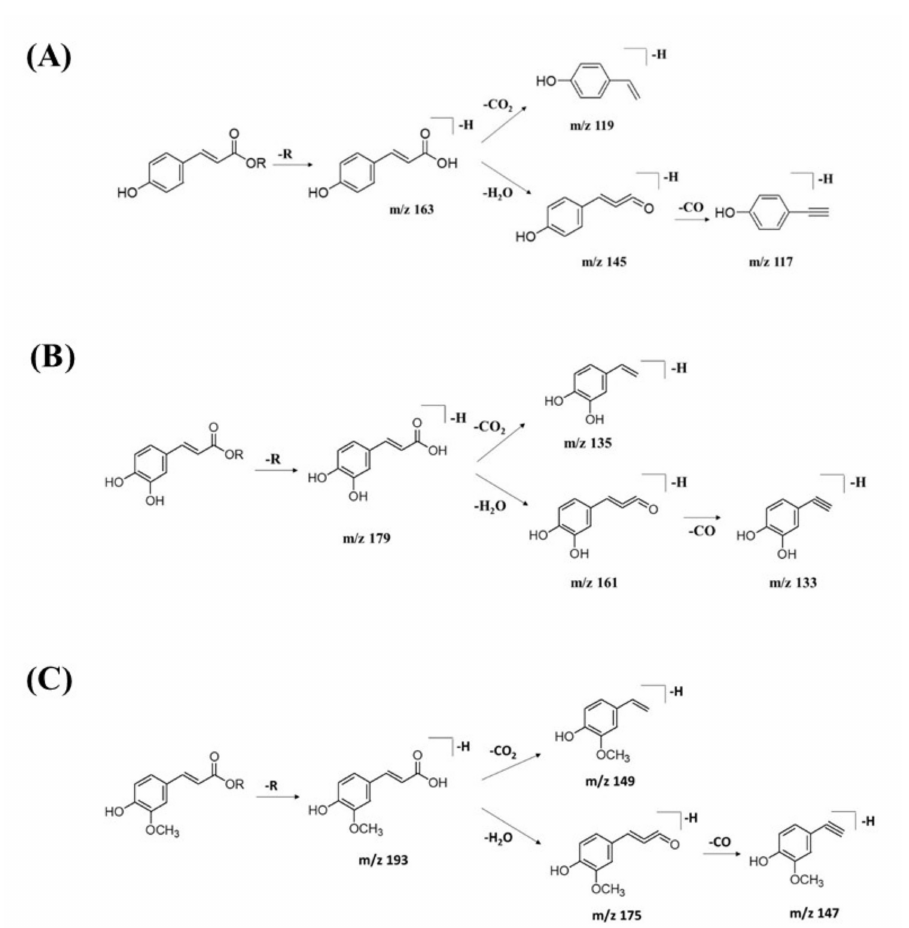
Figure 11. Fragmentation pathway for ( A ) coumaroyl, ( B ) caffeoyl, and ( C ) feruloyl